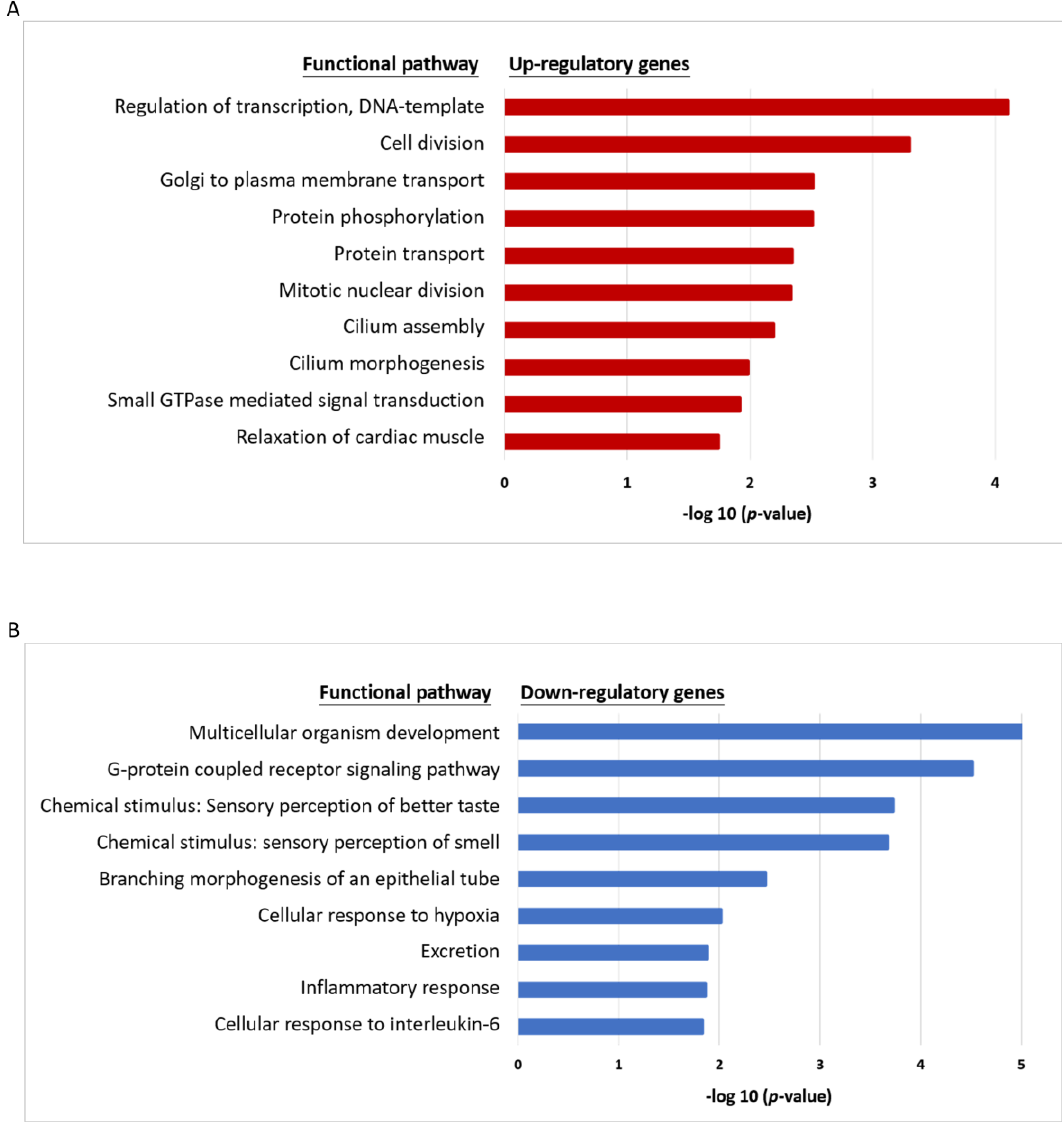
Figure 3. Bioinformatic analysis of the functional pathways associated with CR in HNC cells. ( A ) A list of the top 10 significant molecular functional pathways determined by the Database for Annotation, Visualization, and Integrated Discovery (DAVID) enrichment analysis of the 345 up-regulatory genes. ( B ) A list of the top 10 significant molecular functional pathways determined by DAVID enrichment analysis of the 305 down-regulatory genes. Bar chart representing the classification of Gene Ontology (GO) terms corresponding to biological processes (GOTERM_RP_ DIRECT). The enriched significance ( p ≤ 0.05) values were negative base-10 log-transformed.